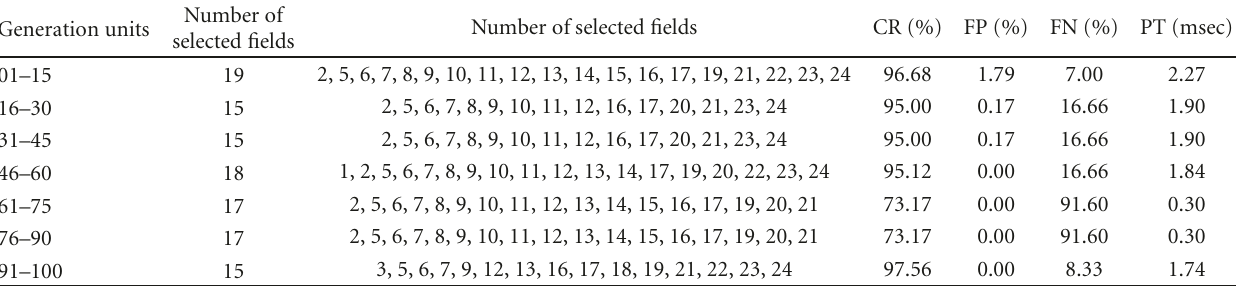
Table 3: GA field selection results of preliminary test